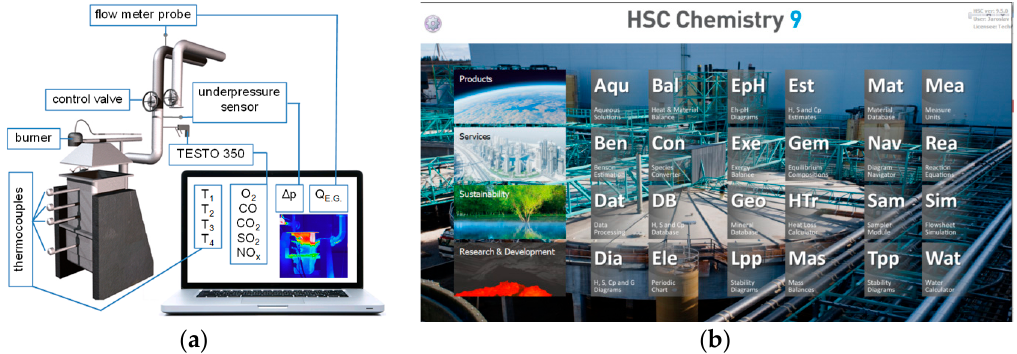
Figure 4. Laboratory sintering pan (LSP) ( a ), and computational program HSC Chemistry—adapted from [16], which has a program license from HSC Chemistry, Outokumpu Research Oy, Pori, Finland, 2018 ( b ).